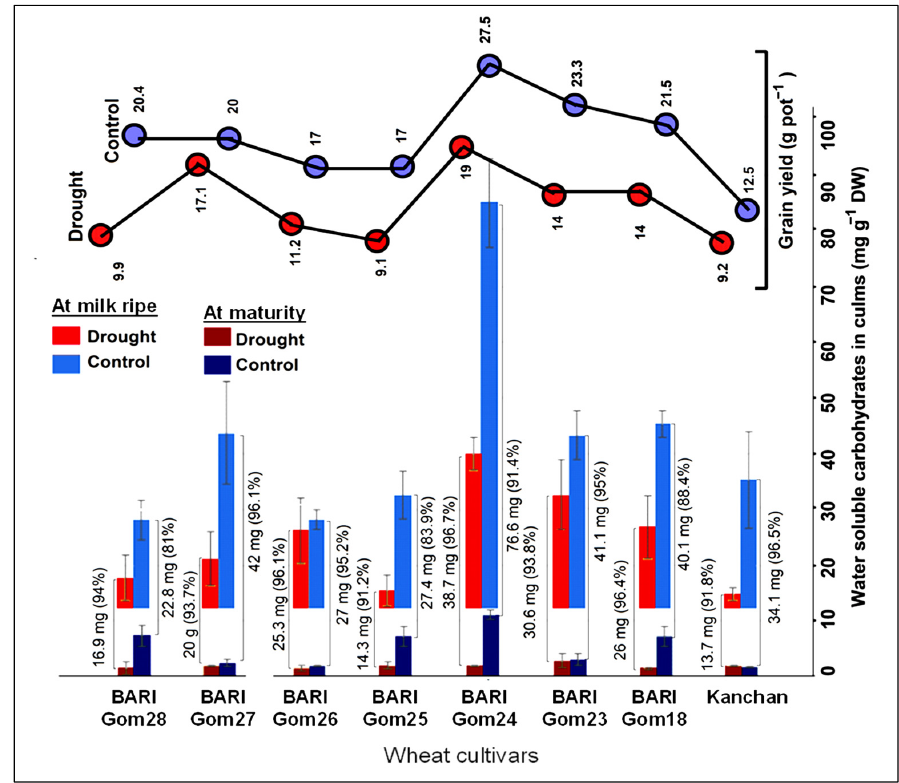
Figure 5. Water-soluble carbohydrates in culm of eight wheat cultivars at milk ripe stage and at maturity (bar chart) as affected by post-anthesis drought stress. Vertical bars represent standard errors of means ( n = 3). The values in mg with percent values in parenthesis along the bars indicate the contents of water-soluble carbohydrate per g culm dry weight at milk ripe with the percent of its remobilization to grain, respectively. Grain yields were overlaid to the histogram to realize the contribution of culm reserves on grain yield setting both at control and drought stress. Values adjacent to data point indicate the grain yields as g pot − 1.